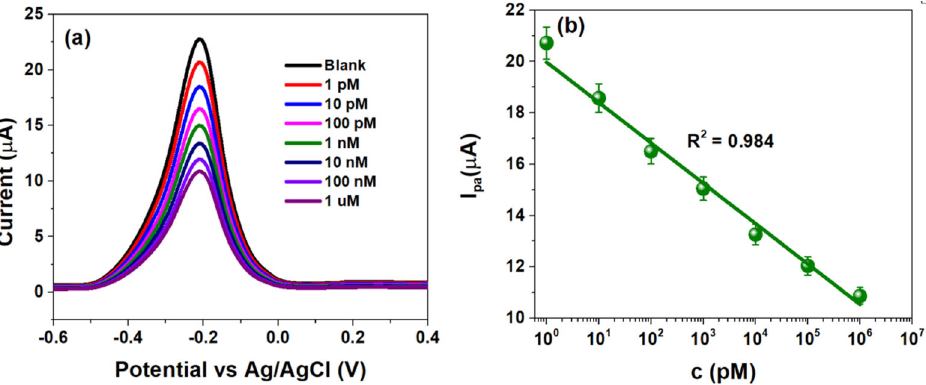
Figure 4. ( a ) Differential pulse voltammograms obtained at HPV ‐ 16 TDNA within 1 pM ‐ 1 μ M and ( b ) sensor calibration obtained at ‐ 0.22 V ( ‐ 220 mV) within the mentioned concentration range. The voltammograms indicate that a decrease in peak anodic currents (I pa ) upon suc ‐ cessive additions of HPV ‐ 16 TDNA as evidenced by an approximately two ‐ fold decre ‐ ment at 1 μ M TDNA from the response of 1 pM TDNA as shown in Figure 4a. The I pa was